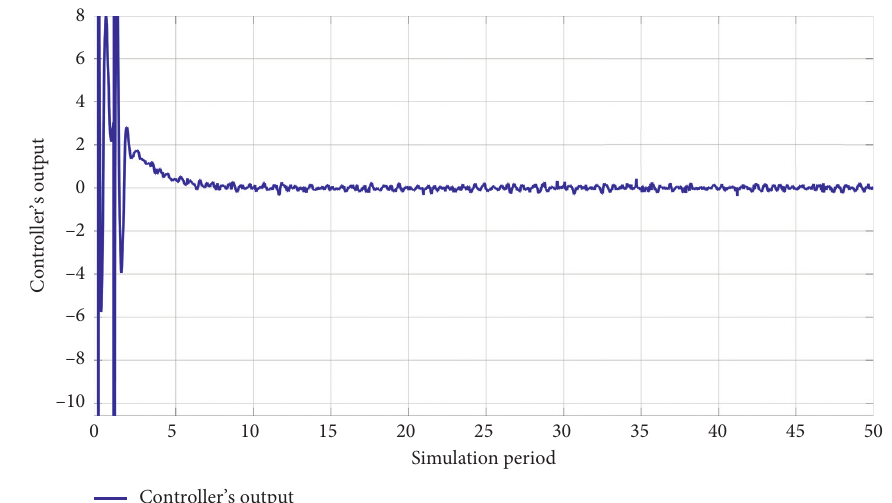
Figure 7: Reference output data (PID controller) of the controller.